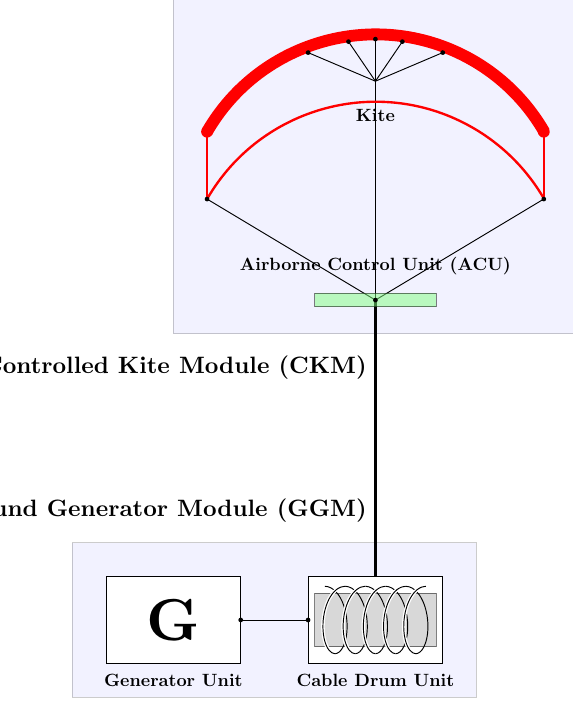
Figure 1. Kite power system components. ACU: airborne control unit; CKM: controlled kite module; GGM: ground generator